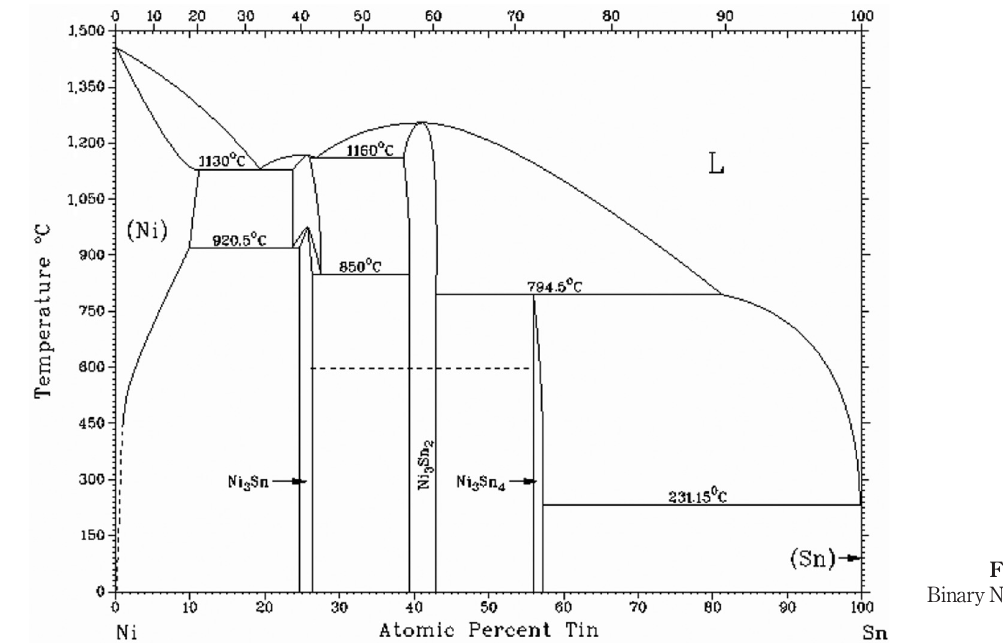
Figure 16. Binary Ni-Sn phase diagram